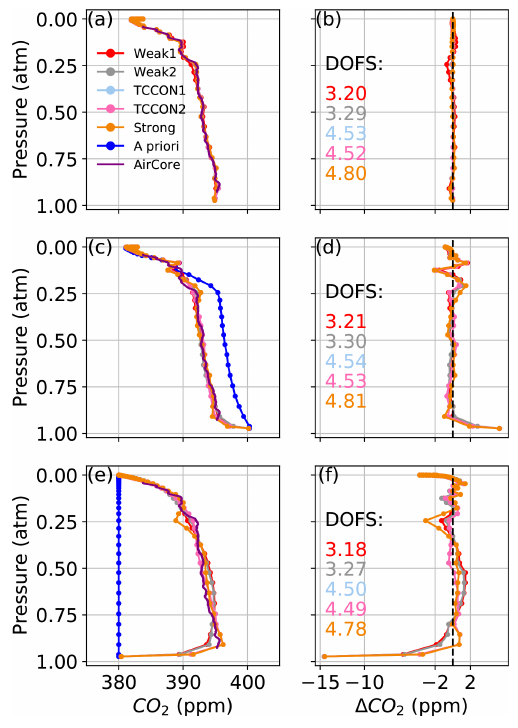
Figure 4. The left-hand panels show CO 2 profiles retrieved using synthetic spectra. In (a) , we use the AirCore profile, which was used to generate the synthetic spectra, as the a priori profile. In (c) , we use the GGG2020 a priori CO 2 profile as the a priori profile. In (e) , we use a constant CO 2 a priori profile. Panels (b) , (d) , and (f) show the difference between the retrieved profiles and AirCore, corresponding to (a) , (c) , and (e) respectively.